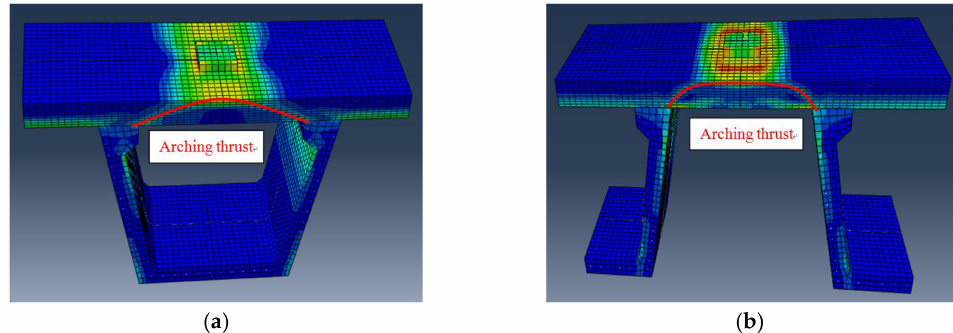
Figure 18. Von Mises stress clouds of the finite element model. ( a ) Von Mises stress cloud for slab loading between the W-beams; ( b ) Von Mises stress cloud for slab loading between W-beams and W-beams.